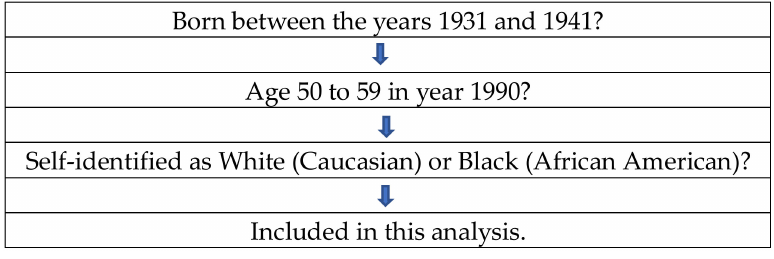
Figure 1. The flowchart of participants’